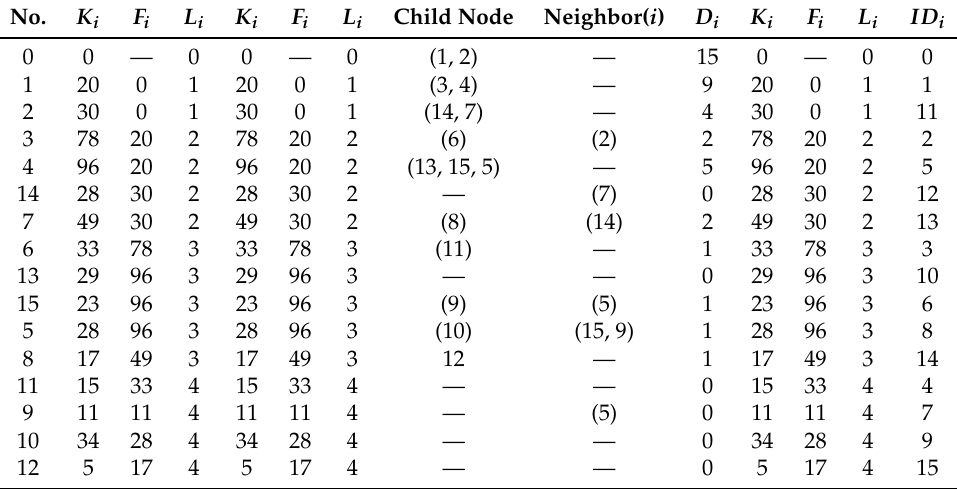
Table 2. The proposed protocol operation and state information for each